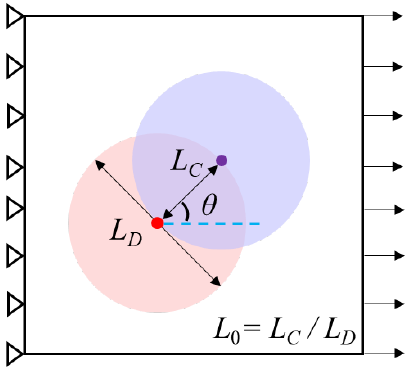
Figure 12. Schematic diagram of repeated needling region.